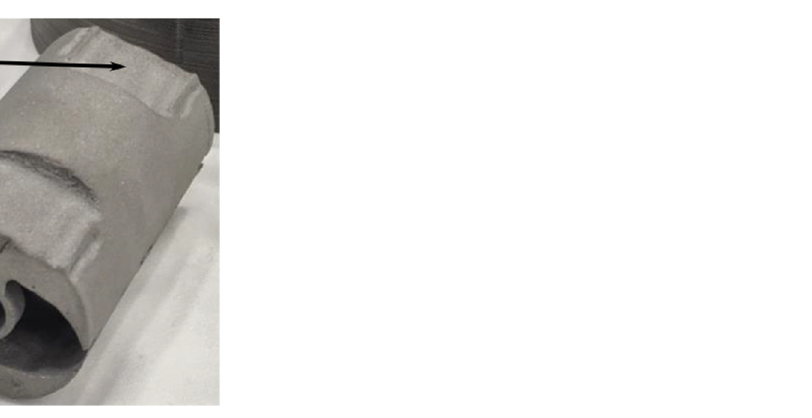
Figure 14. 3D ‐ printed low ‐ mass PMSM rotor with special locations for placing the PMs, repro ‐ Figure 14. 3D-printed low-mass PMSM rotor with special locations for placing the PMs, reproduced duced with permission from the owner, Garibaldi, M. [152]. with permission from the owner, Garibaldi, M.